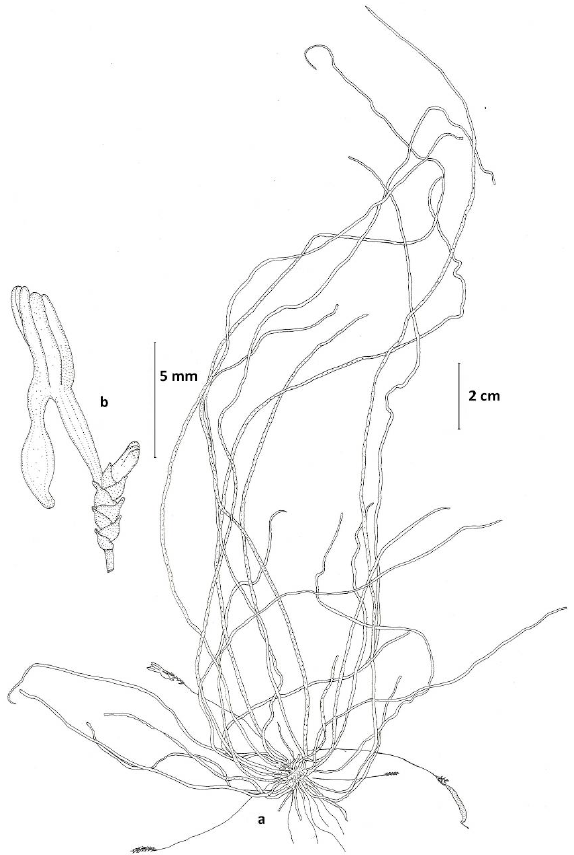
Image 2. Taeniophyllum filiforme close up view of